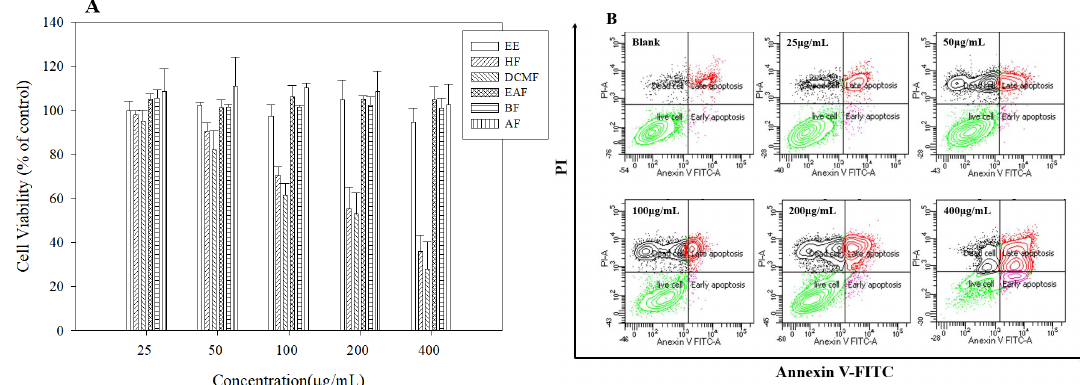
Figure 3. Cell viability of R crispus extracts and solvent fractions. ( A ) apoptosis induced ( B ) in HepG2 cells. HepG2 cells were treated with various concentrations (25, 50, 100, 200, 400 µ g / mL) of R. crispus extracts and fractions for 24 h. Cell viability was measured by MTT assay. Flow cytometry analysis of apoptosis after exposure to various concentrations (25, 50, 100, 200, 400 µ g / mL) of DCMF for 24 h, using annexin V-FITC / PI. The lower right indicates the percentage of early apoptotic cells; the upper right indicates the percentage of necrotic and late apoptotic